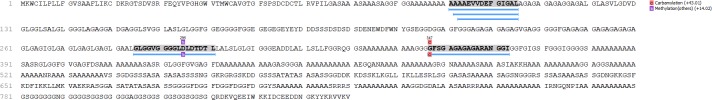
HorB - Hic74 coverage.